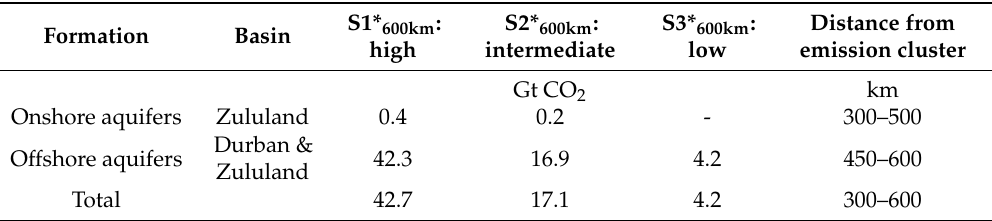
Table 5. Three scenarios of effective CO 2 storage capacity in South Africa considering only basins with a maximum distance of 600 km from the main emission cluster.